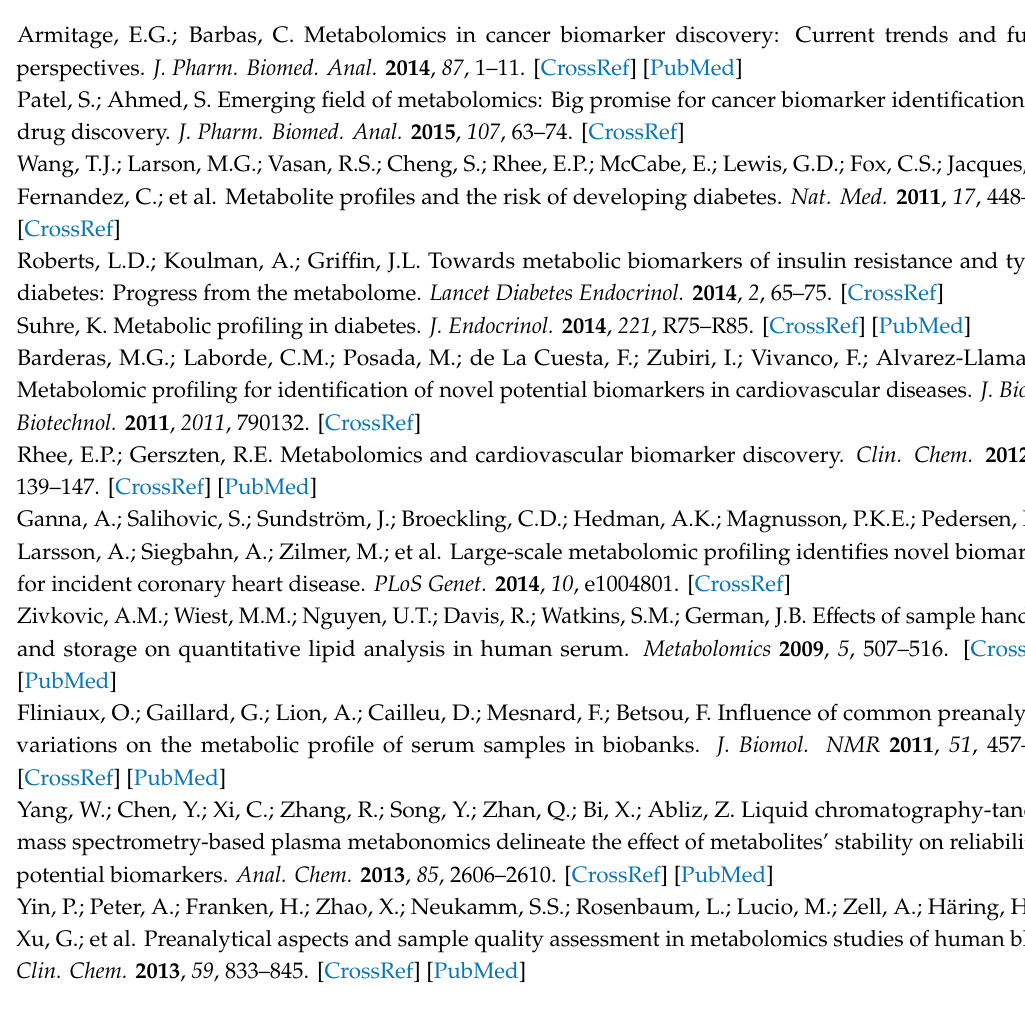
Table S1. Impact of di ff erent storage times at − 80 ◦ C on human plasma metabolite concentrations. Table S2. Results of OPLS models with storage time as Y-variable in di ff erent subject age groups. Figure S1. Shared and Unique Structures (SUS) plot comparing contribution of metabolites to the separation of samples according to storage time by